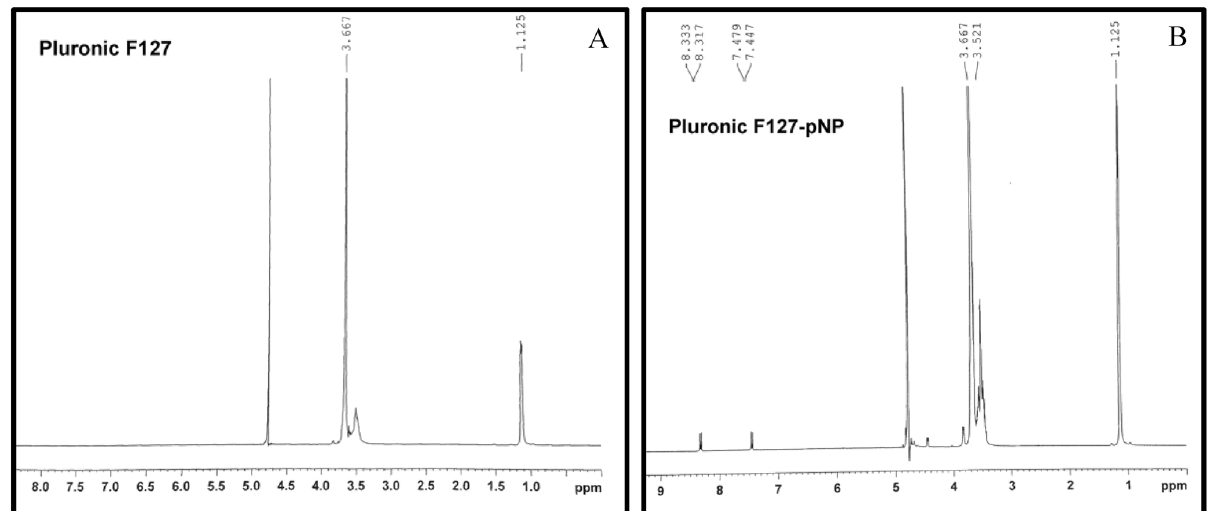
Figure 2. 1 H-NMR spectra of Pluronic-F127 ( A ) and p-nitrophenyl chloroformate activated Pluronic F127- pNP ( B ) in D 2 O. δ = 1.125 ppm (–CH 3 protons in PPO blocks in Pluronic chain), δ = 3.5 ppm (–CH and – CH 2 units of PPO block in Pluronic chain), δ = 3.66 ppm (–CH 2 CH 2 units of PEO blocks in Pluronic chain), δ = 7.447/7.479 and 8.317/8.333 ppm ( p -nitrophenyl doublet proton